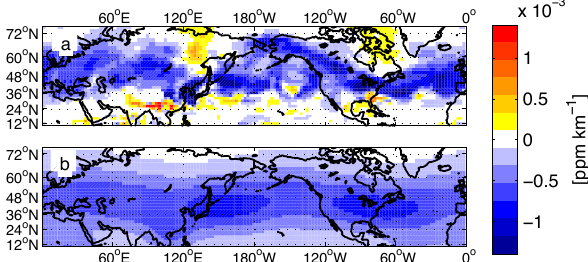
Fig. 10. August gradients in simulated h CO 2 i . (a) Estimated gradi- ent \ ∂ y h CO 2 i calculated at each gridbox from variations in h CO 2 i and θ . (b) Actual meridional gradient in h CO 2 i smoothed over 1500km.